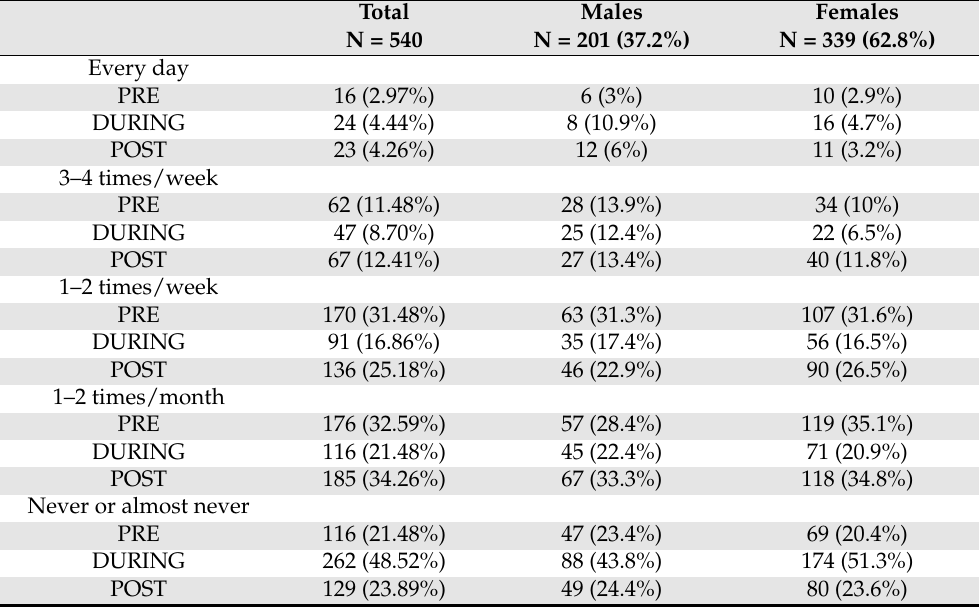
POST ( ϕ c = 0.709, p < 0.001), Cramer’s V) (Table 6). Table 6. Alcohol consumption of the study